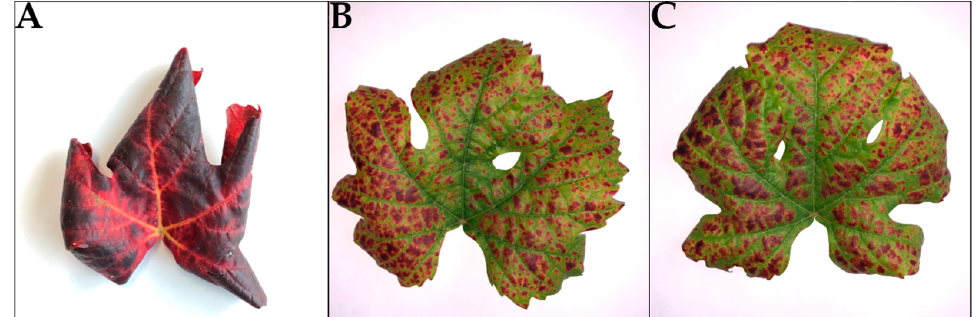
Figure 6. Transmission experiment using Pseudococcus comstocki to disentangle mixed viral infection. Original viral source on Pinot noir was displaying very severe symptoms of leafroll disease ( A ), whereas mealybug transmitted grapevine leafroll-associated virus 3 (GLRaV-3) ( B ) and mixed-infection GLRaV-3 grapevine virus B ( C ) on Pinot noir were causing milder leafroll symptoms.